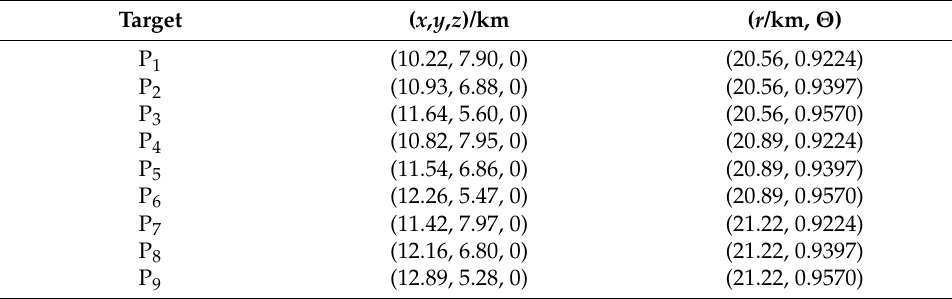
Figure 6. Trajectory deviations.